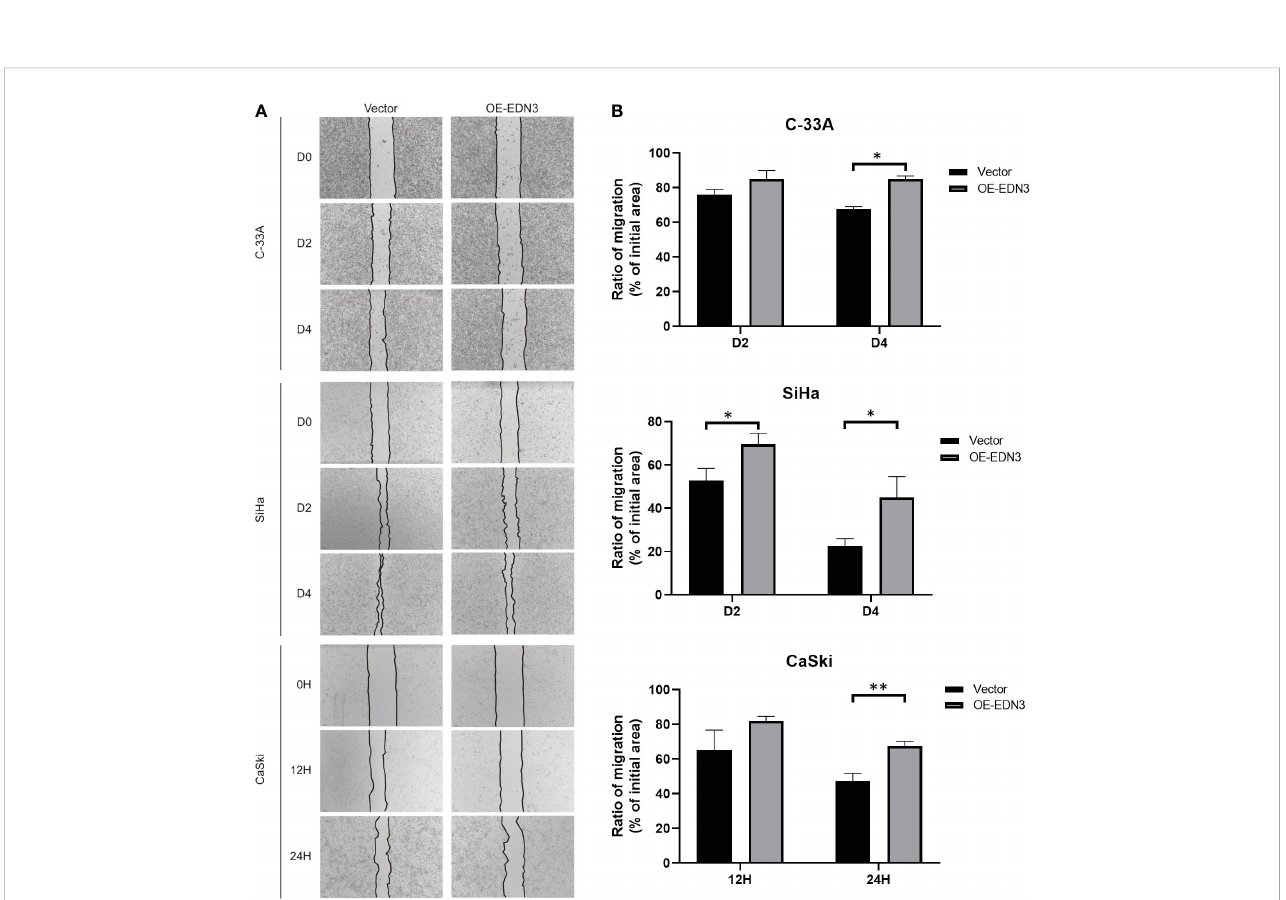
FIGURE 5 Overexpression of EDN3 inhibited the migration of C-33A, SiHa and CaSki cells by wound healing assay. (A) Representative images of wound healing assay using C-33A, SiHa and CaSki cells transfected with OE- EDN3 or vector. (B) Quanti fi cation of wound healing assay is shown. Values are mean ± SD, N = 3; *P<0.05;